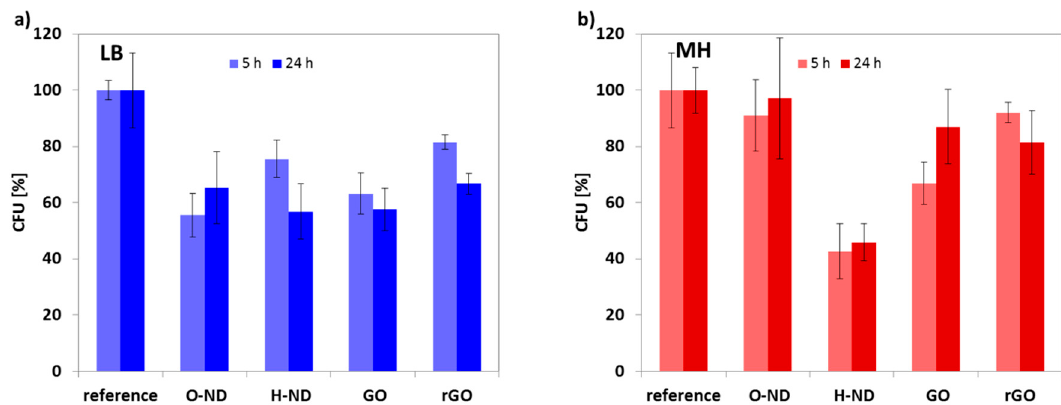
Figure 2. Comparison of Petri dishes cultured using ( a ) the E. coli reference sample and ( b ) the E. coli sample exposed to HND in the LB medium for 5 h.